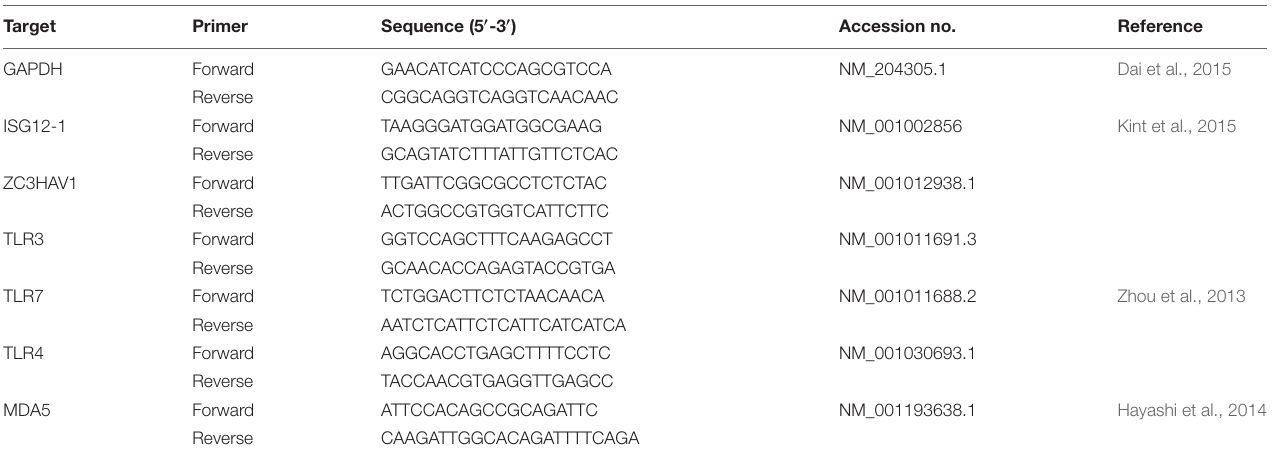
TABLE 1 | qRT-PCR